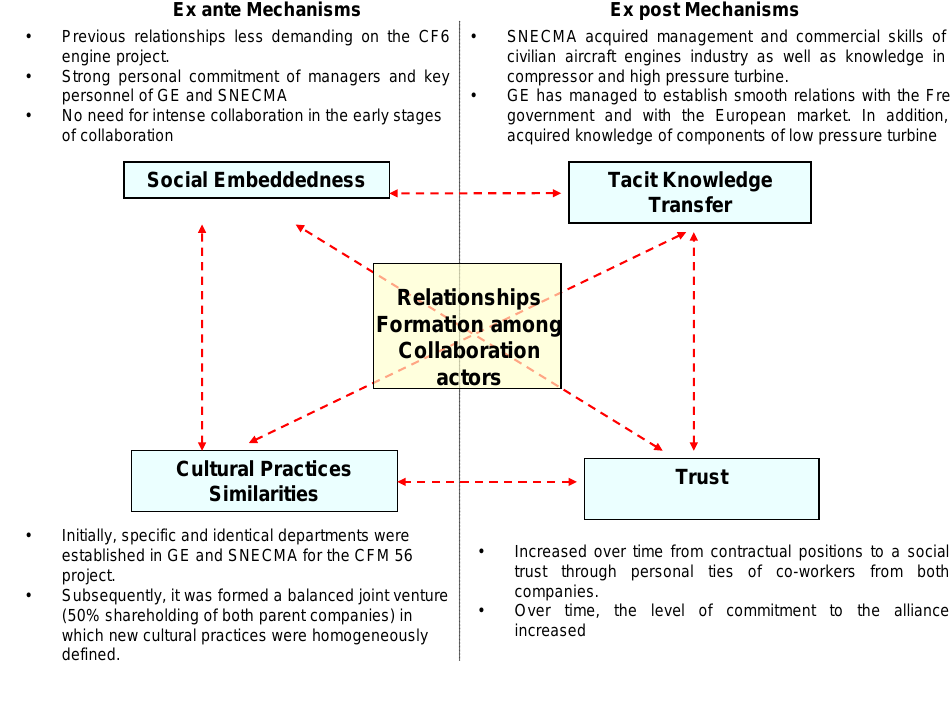
Figure 8. “Cultural mechanisms at GE-SNECMA collaboration to manufacture the CFM56